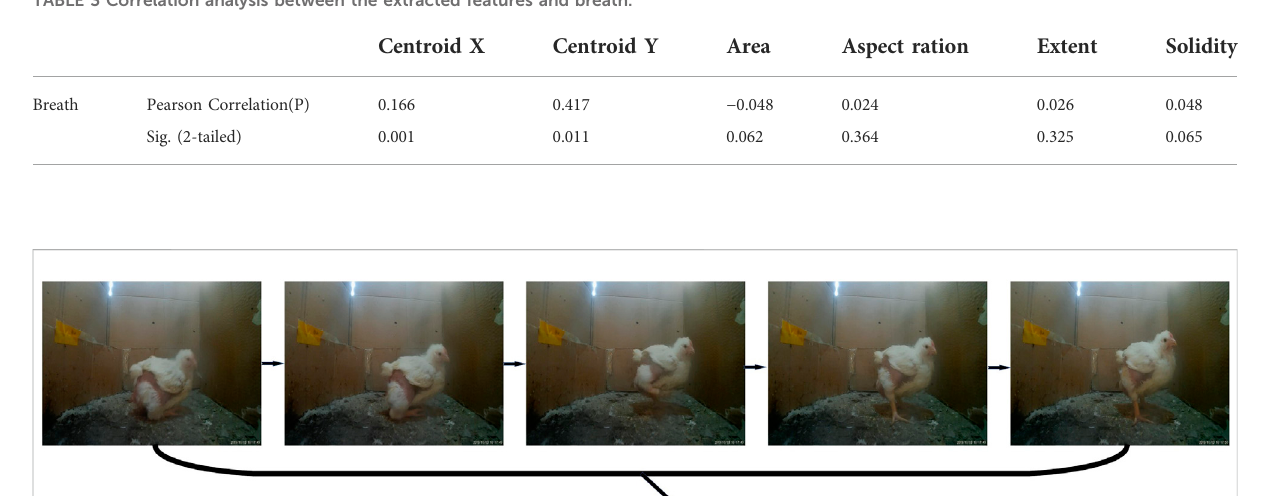
TABLE 3 Correlation analysis between the extracted features and breath.